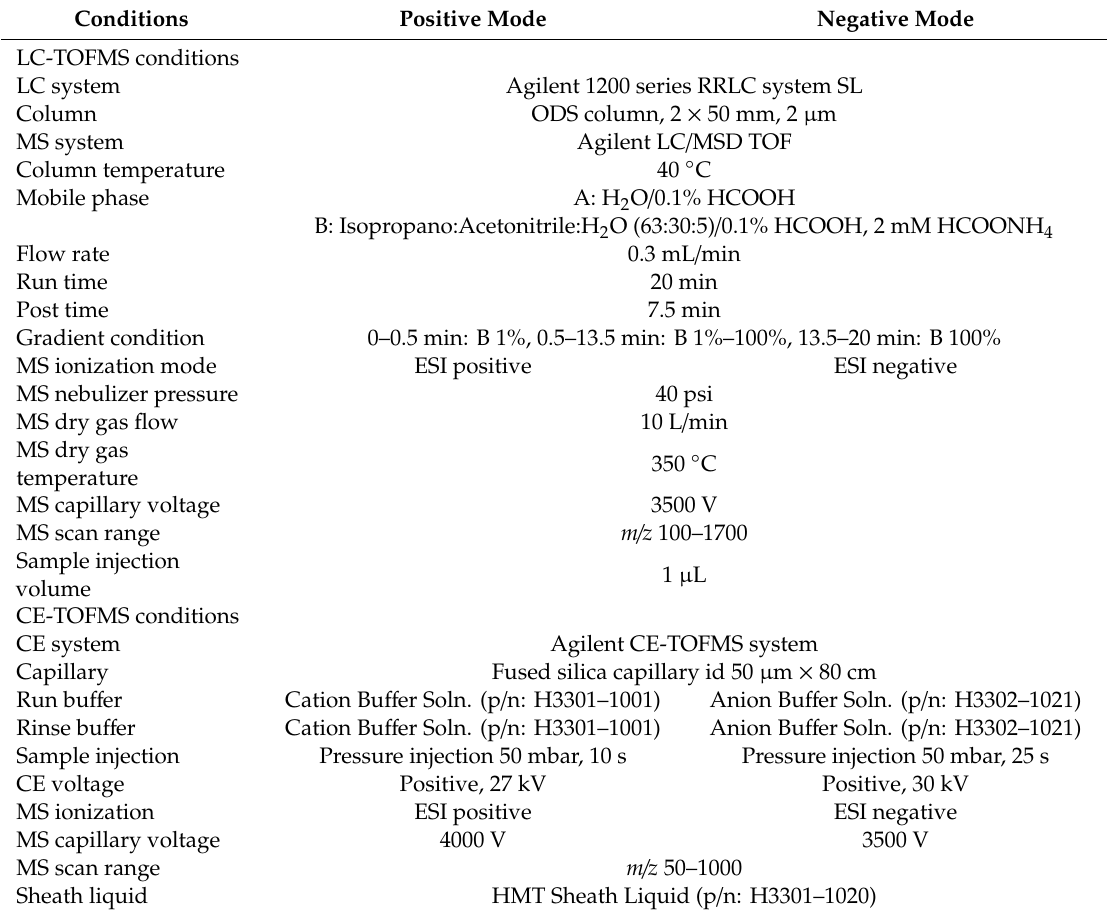
Table 3. Summary of the analytical conditions of liquid chromatography (LC)- and capillary electrophoresis time-of-flight mass spectrometry (CE-TOFMS) analyses used in this